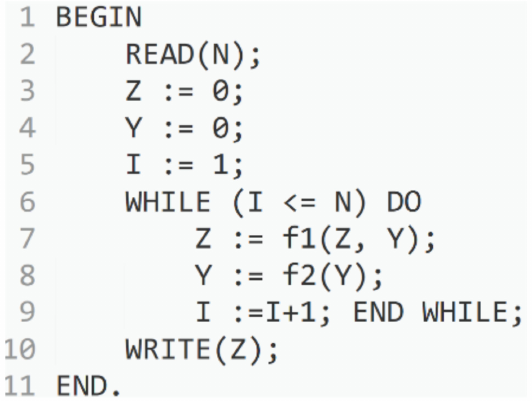
Figure 4. Dynamic slicing sample